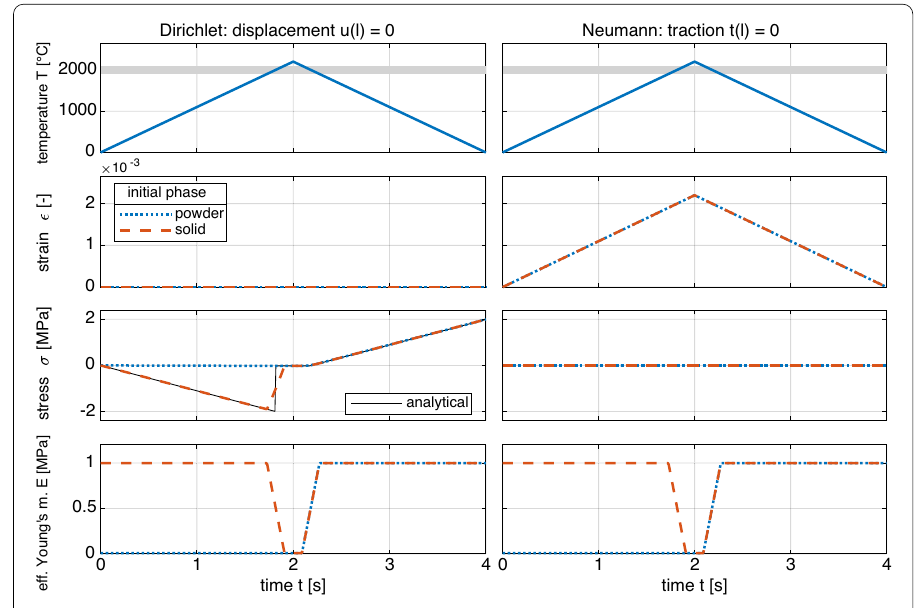
Fig. 3 Stress and strain over time for the Dirichlet and Neumann scenario with initially powder or solid material induced by a full melt. Simulation is driven by a homogeneous temperature load with a single peak > T l . Phase change interval in gray T peak